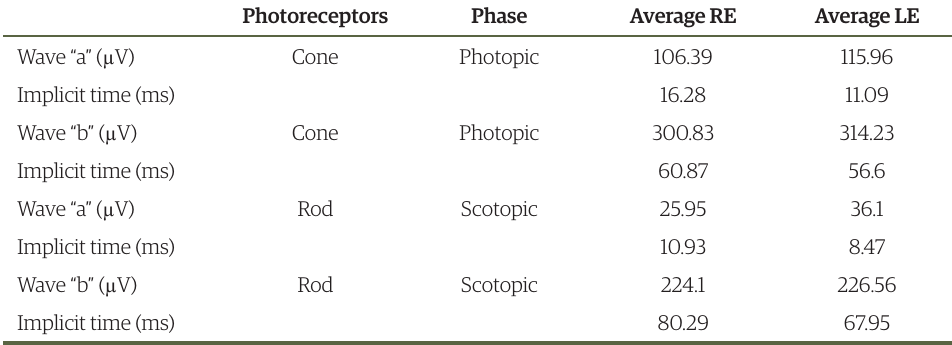
Table 1. Average amplitudes of waves “ a ” and “ b ” in the photopic and scotopic stimulus phases, in the left (LE) and right (RE) eye of normal horses submitted to total field electroretinography (Adapted of Rosa et al.,